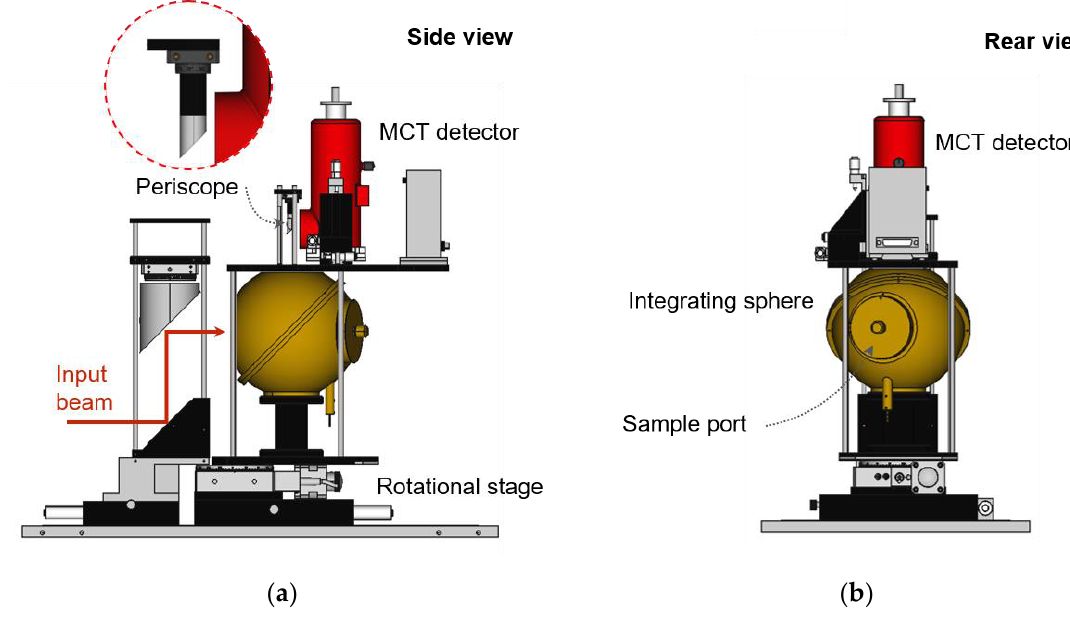
Figure 2. ( a ) Side view and ( b ) rear view schematic images of the absolute reflectometer.